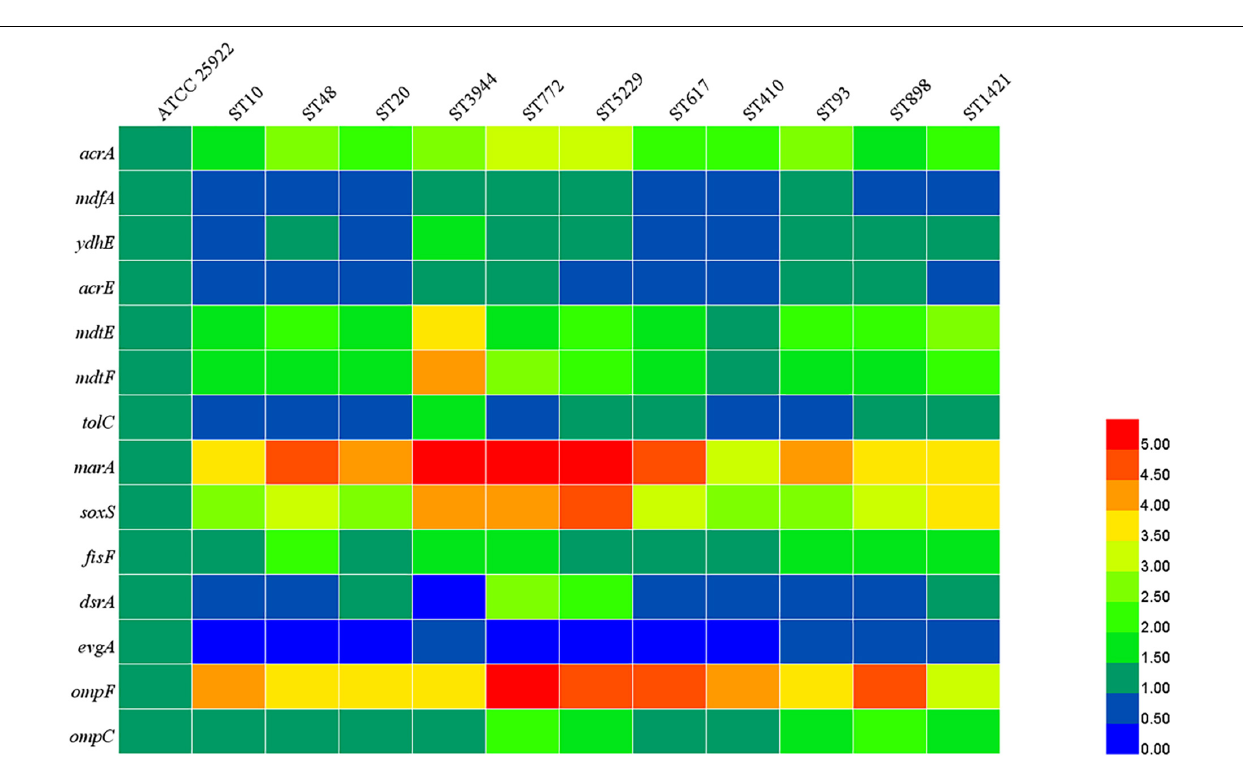
FIGURE 4 | Relative expression levels of efflux pumps, porins, and regulators. The different colors indicate the different expression